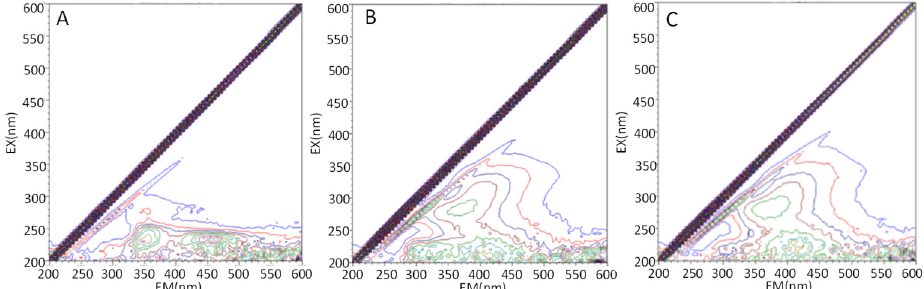
Figure 11. 3D EEM spectra for high-strength synthetic batik wastewater containing 96 mg/L RB5 and 96 mg/L RO16 treated by ozonation for 0 min ( A ) and 30 min ( B ); and ozonation for 30 min followed by biodegradation for 14 days ( C ). All samples were 10-fold diluted for analysis.